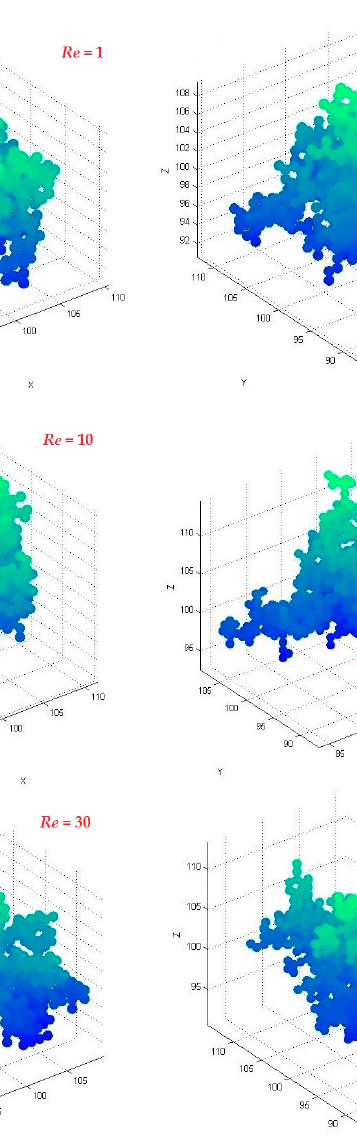
Figure 8. 2D DLA aggregates with various launch radii.